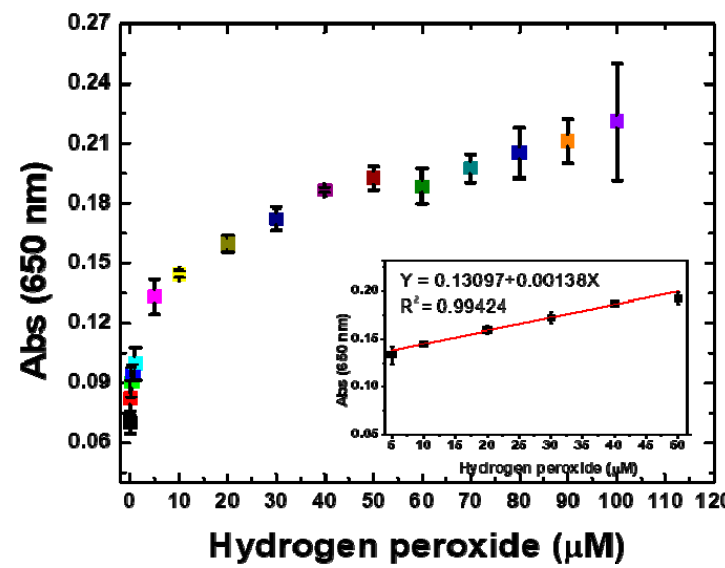
Figure 8. Sensitivity of the assay for H 2 O 2 detection: UV/Vis absorbance values at 650 nm vs. H 2 O 2 concentration (0.0625–100 μ M); the assay exhibited a linear response at low concentrations.